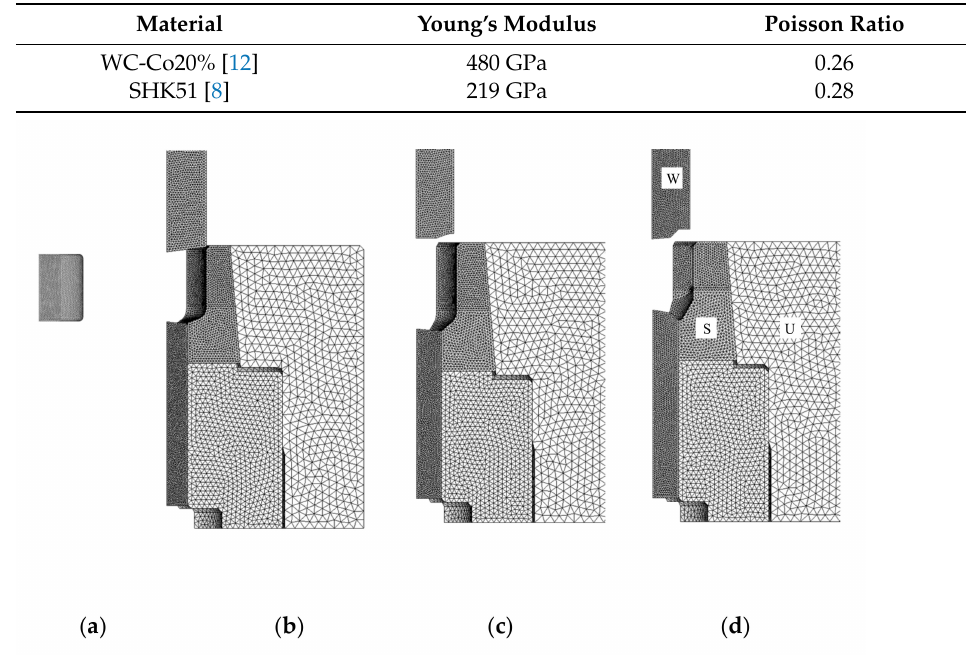
Figure 2. Flow curve of the material S25C. Table 1. Mechanical properties of the die materials.